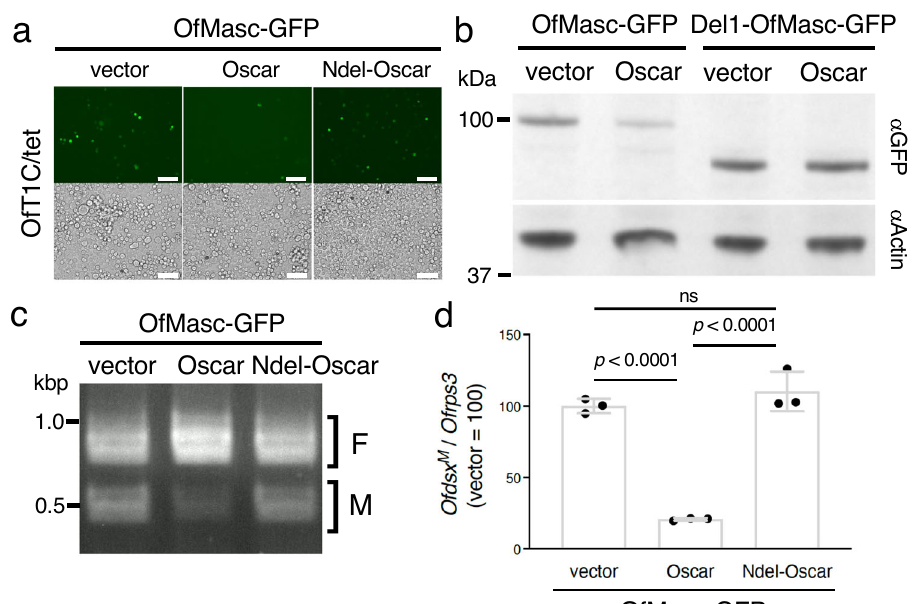
Fig. 3 | Oscar inhibits OfMasc accumulation and OfMasc-induced masculiniza- tion in cultured cells. a Fluorescence microscopy of OfT1C cells co-transfected with OfMasc-GFP and empty vector or Oscar cDNAs. Bar, 100 µ m. Similar results wereobtainedintwoindependentexperiments. b AccumulationofOfMasc-GFPor Del1-OfMasc-GFP in Oscar-expressed OfT1C/tet cells. Actin was used as a normal- ization control. Similar results were obtained in two independent experiments. c Splicing patterns of Ofdsx . OfT1C/tet cells were co-transfected with OfMasc-GFP